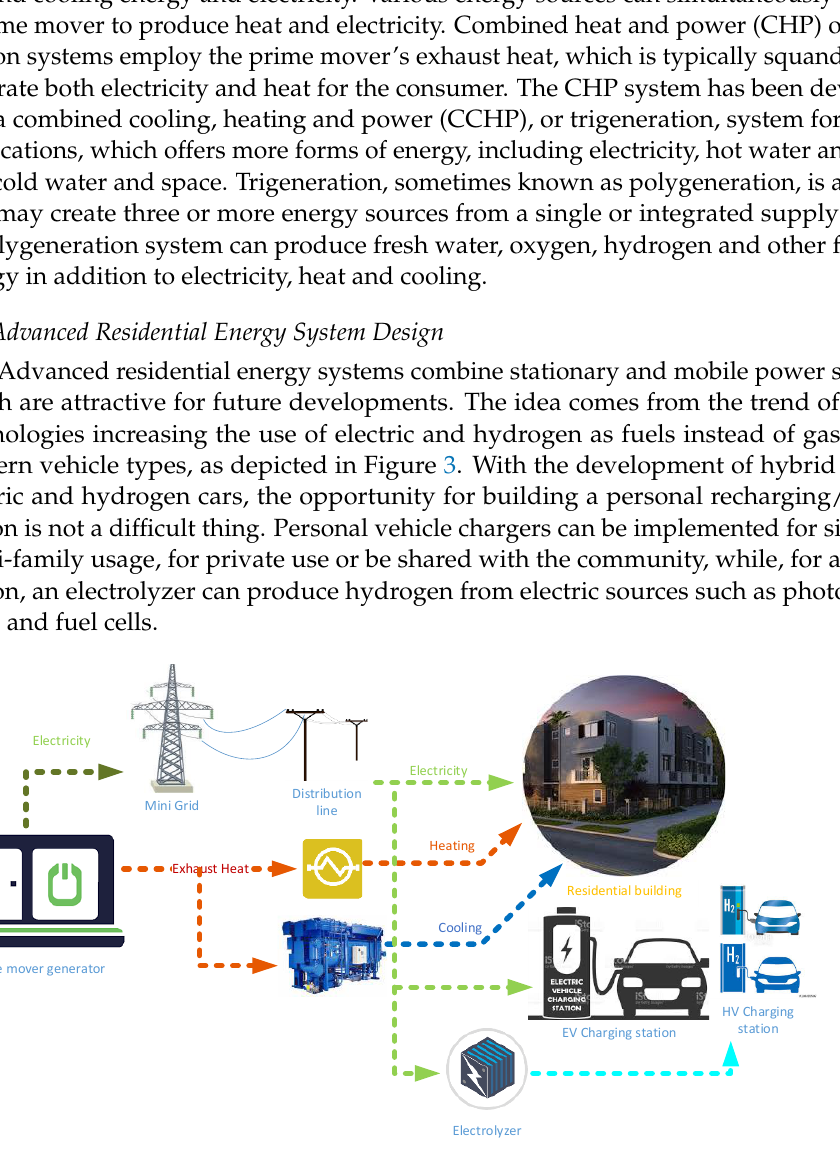
Figure 3. Advanced energy system design with a vehicle charging/fueling station in a residential